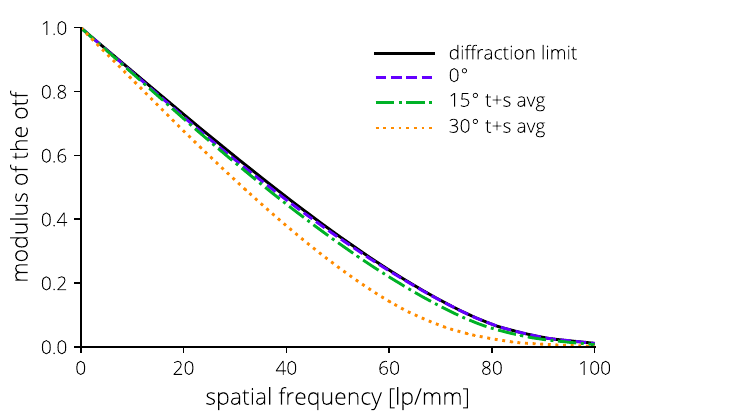
Fig 4. Nominal MTF of the intraoral probe at the tissue plane with the sagittal and tangential data averaged.